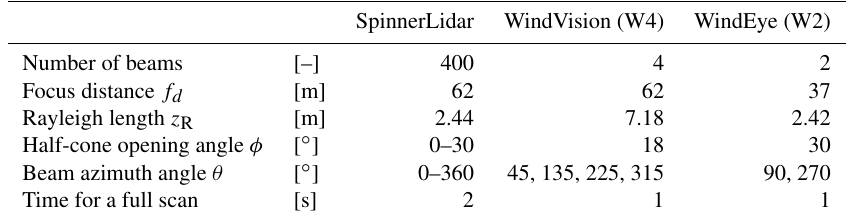
Figure 4. (a) The scanning trajectory of the nacelle lidars. (b) An upwind view of the theoretical scanning pattern performed by the W2, W4 and the SpinnerLidar. Table 1. Specifications of the nacelle lidars for the measurement